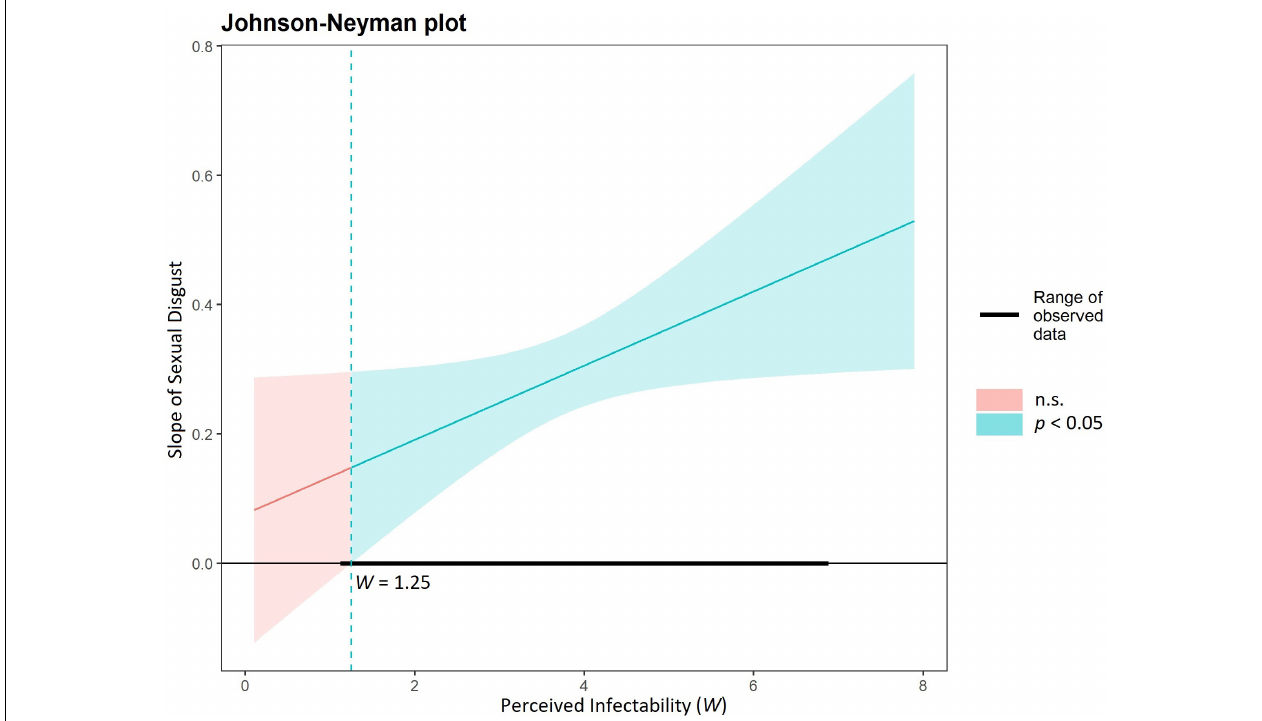
FIGURE 2 | Regions of significance for the conditional effect of sexual disgust presented for perceived infectability as a moderator and negativity toward lesbians as the outcome